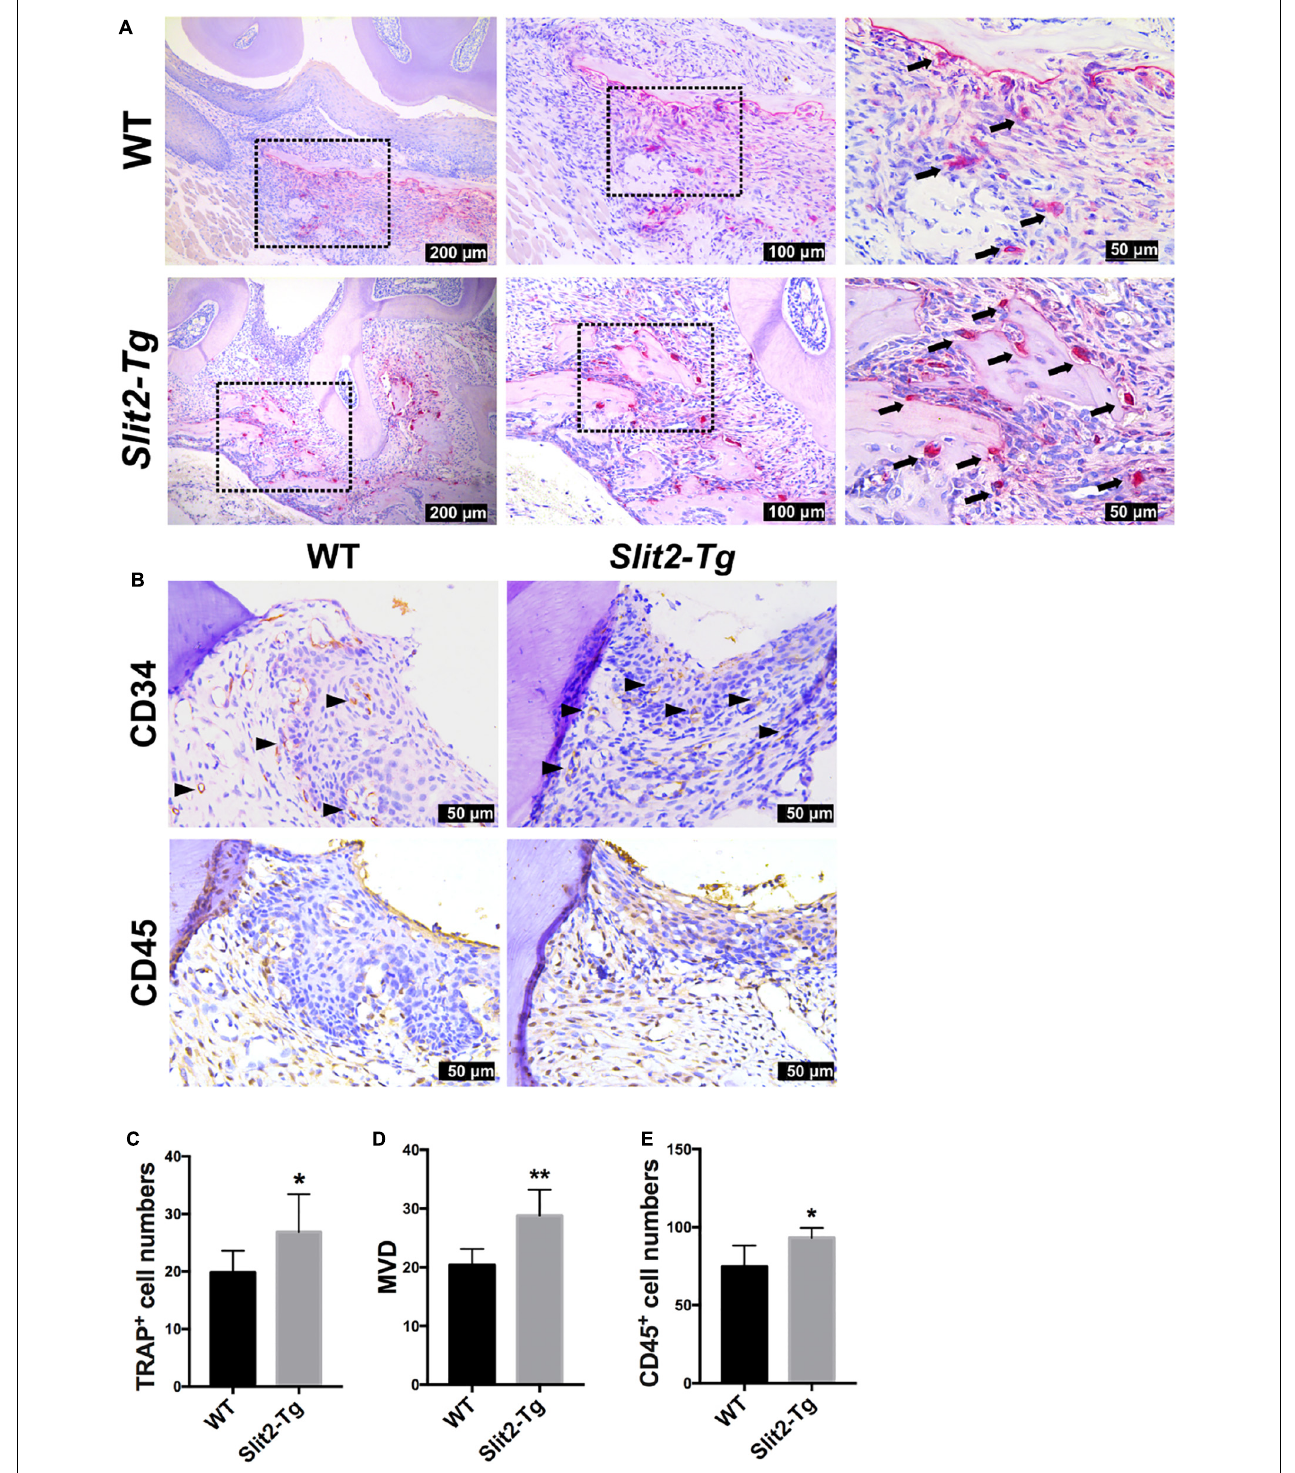
FIGURE 2 | SLIT2 overexpression augments pathological changes in both periodontal milieu soft and bone tissues during periodontitis. (A) Representative histological images of PAPT sections showing TRAP+ osteoclasts. (B) Representative CD34 and CD45 immunohistochemistry images of PAPT sections. (C) Quantitative analysis of osteoclasts from TRAP-stained histological tissue sections ( n = 6). (D) Quantification of micro-vessel density from CD34 immunohistochemistry images ( n = 5). (E) Quantification of CD45 expressing cells from CD45 immunohistochemistry images ( n = 6). The significant difference among the groups, * P < 0.05, ** P < 0.01. Black arrow: TRAP+ multinucleated osteoclasts. Black triangle arrowhead: microvessel. WT: wild-type.